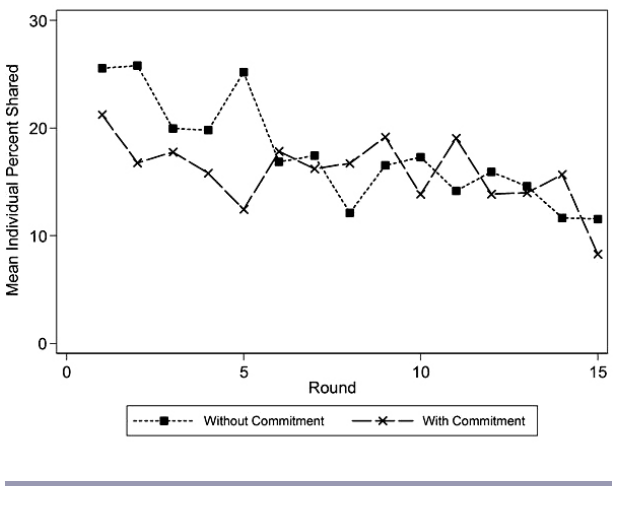
Fig. 3 . Mean individual percentage shared.